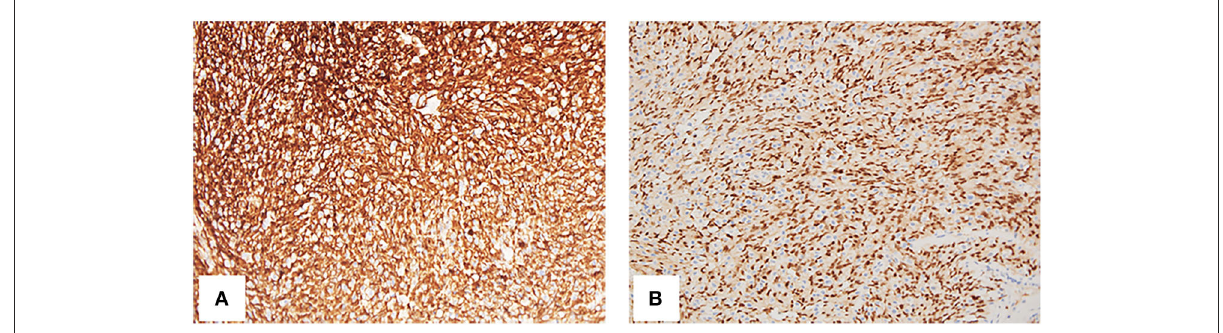
FIGURE4 Histology of resection from the left lower lung nodule. The spindle cells are CD34 ( A , 200 × ) and ERG (ETS-related gene) ( B , 200 × ) positive.